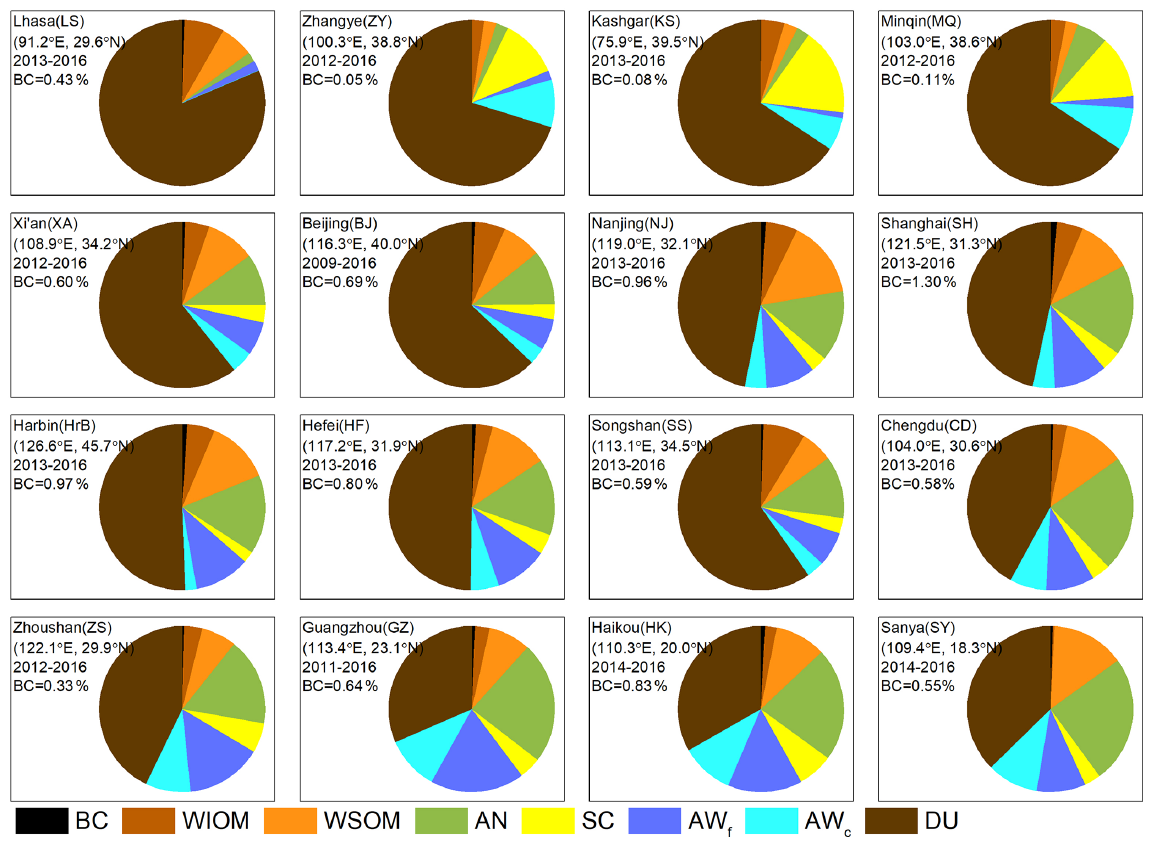
Figure 7. The averaged mass fraction of aerosol components at SONET sites. The site name, location, observation period and BC fraction are marked in each subgraph. The mass fractions of other components are listed in Table